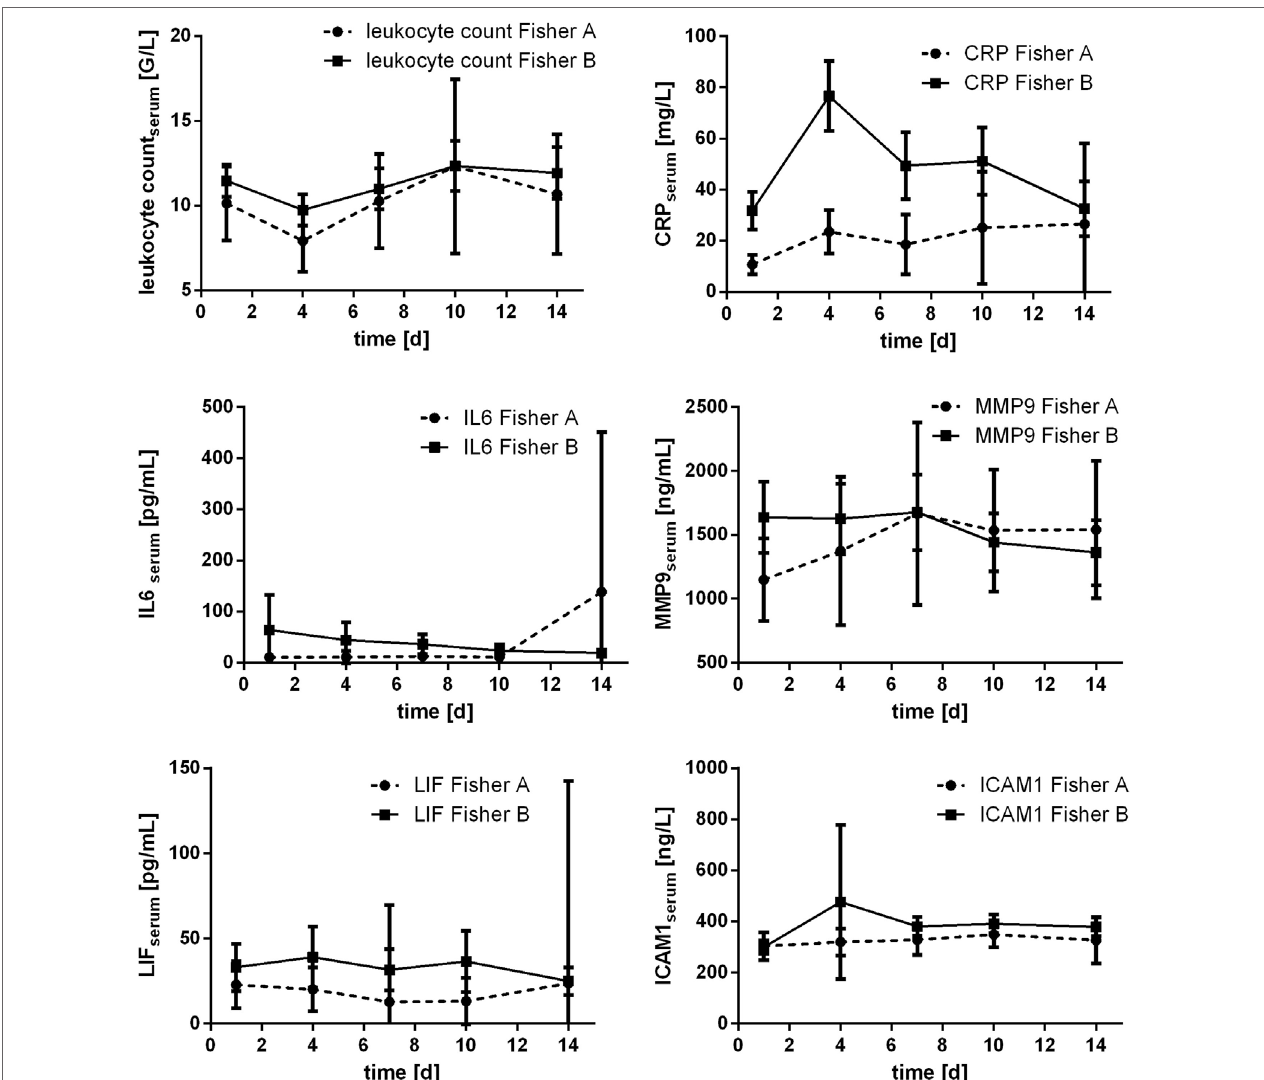
FigUre 8 | Courses of serum inflammatory parameters related to dichotomized Fisher scale score ( ± 95% confidence